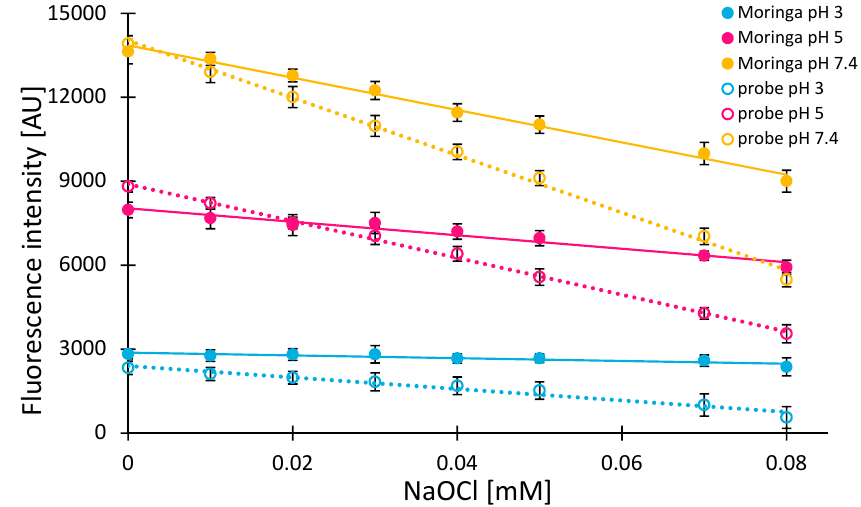
Figure 4. Comparison of changes in fluorescence intensity of 7-DCCA (0.04 mg/mL): under the influence of NaOCl (dotted lines), and, after 15 min of Moringa extract (0.5 mg/mL), incubation with NaOCl (permanent lines). The measurements were carried out at λ Ex 289 nm, λ Em 460 nm, and at a temperature of 25 °C.